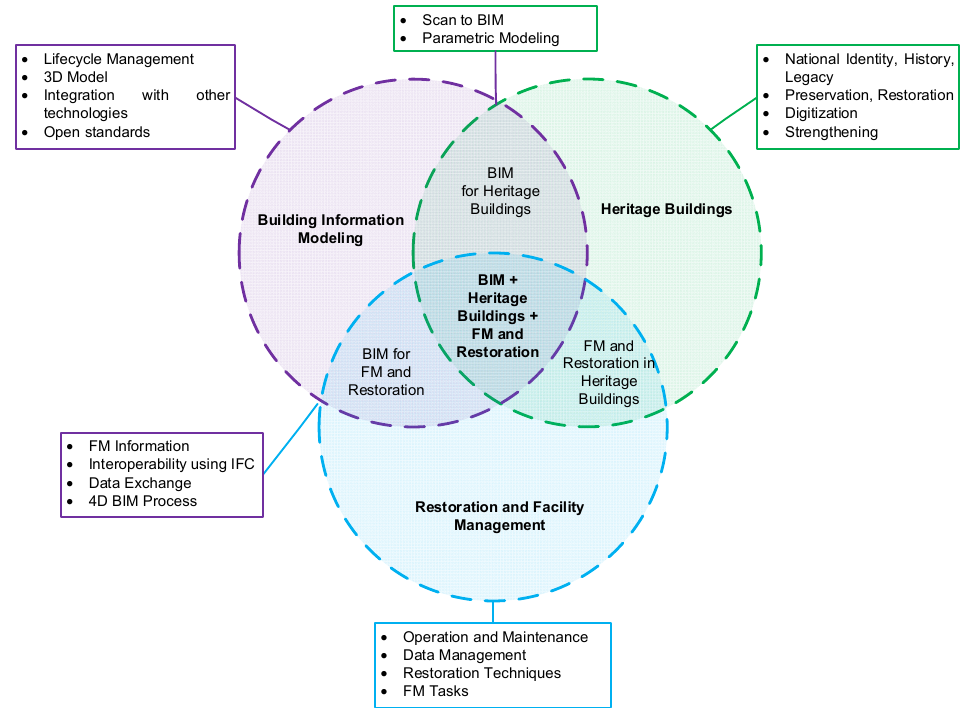
Figure 1. Literature analysis Venn diagram.